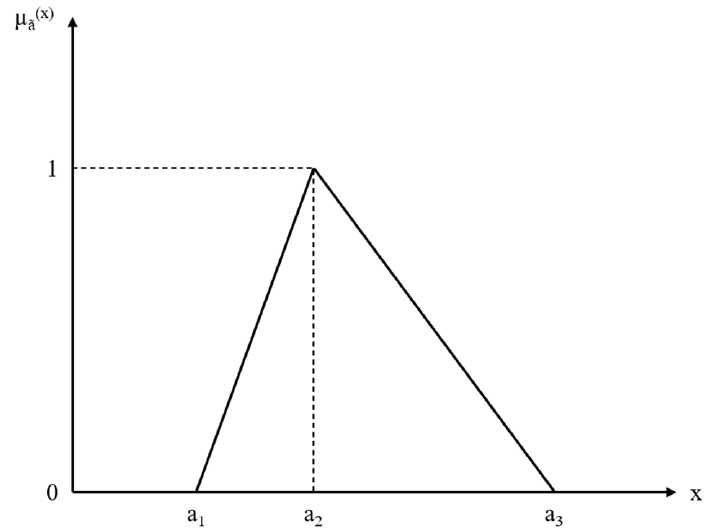
Figure 2. A triangular fuzzy number ã .